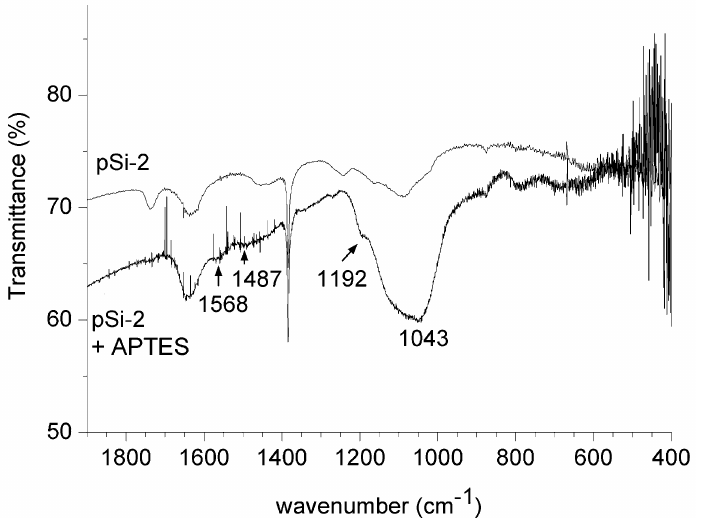
Figure 6. FT-IR spectra for porous sample milled 2 h and the same sample after silanization with